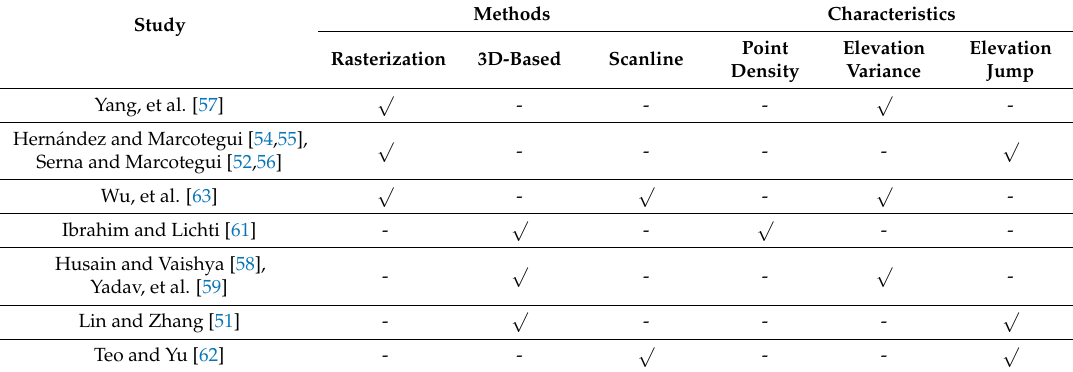
Table 3. Summary of studies in ground extraction for MLS